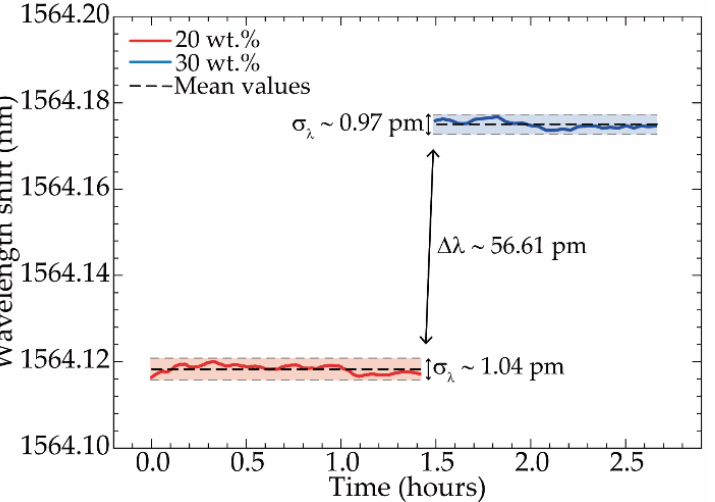
Figure 6. Sensor’s wavelength stability over a period of 90 min, for the two gaseous ethanol concentrations of 20 wt.% (red) and 30 wt.% (blue). The red and blue shadowed zones represent the data standard deviation for each ethanol concentration step, denoted by σ λ .